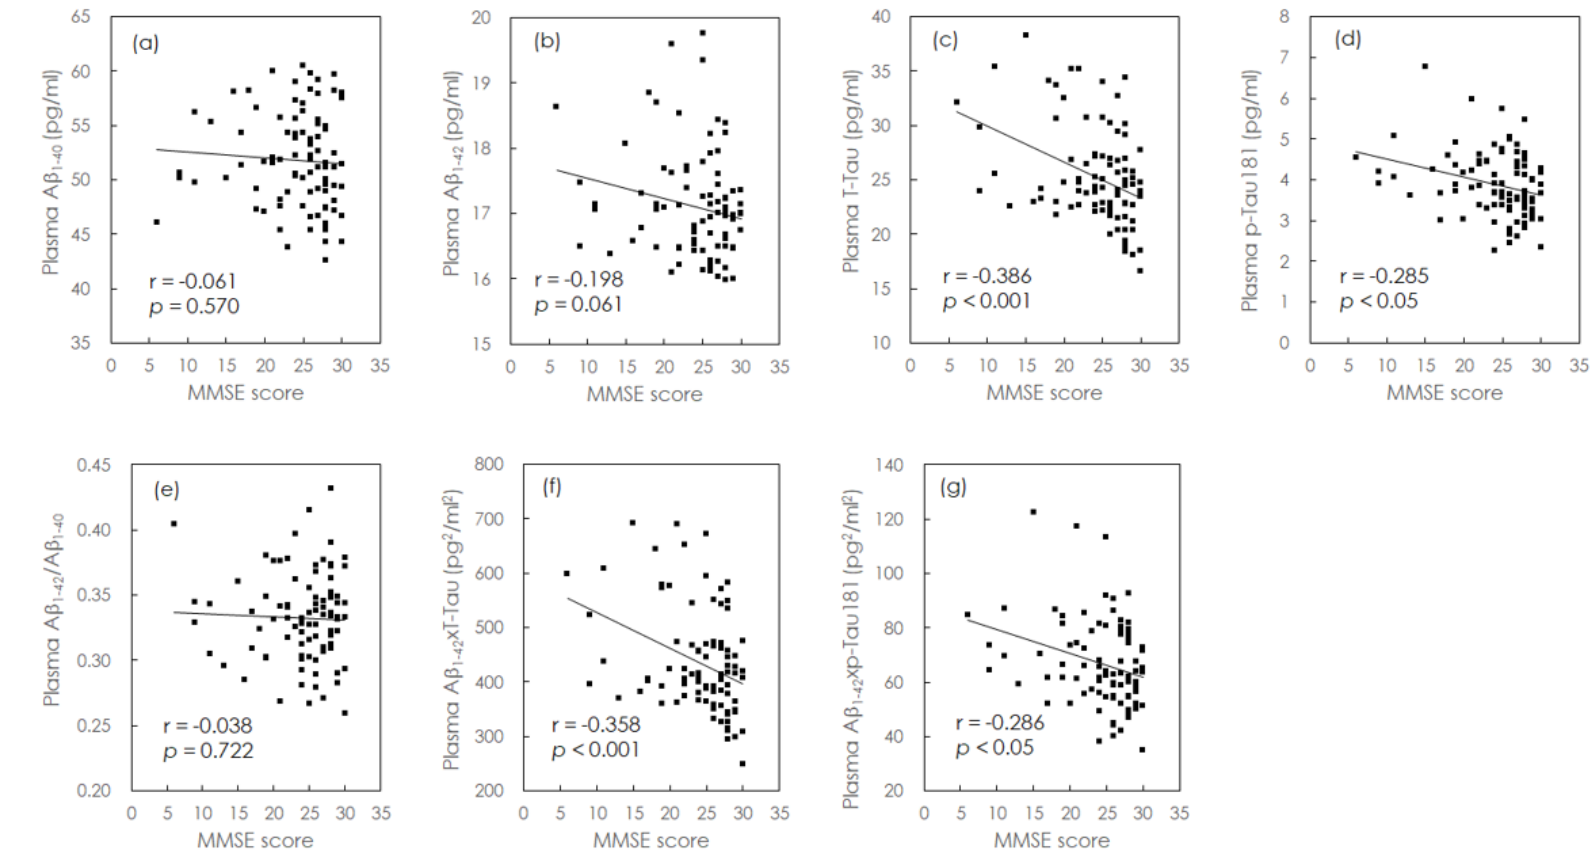
Figure 1. Individual and combined plasma biomarkers. Levels of ( a ) A β 1-40 , ( b ) A β 1-42 , ( c ) t-Tau ( d ) p-Tau181, ( e ) A β 1-42 / A β 1-40 , ( f ) A β 1-42 × t-Tau, and ( g ) A β 1-42 × p-Tau181 versus MMSE scores for the 90 participants (HCs, aMCI, and AD) in the cross-sectional analysis. A β : amyloid- β ; MMSE: mini-mental state examination; HC: healthy control; aMCI: amnestic mild cognitive impairment; AD: Alzheimer’s disease; t-Tau: total tau; p-Tau181: phosphorylated tau